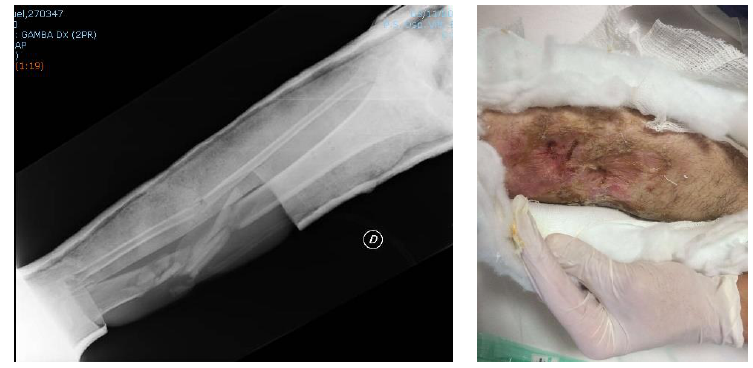
Figure 8. Radiograph of the right leg and image of the soft tissue in November 2016.